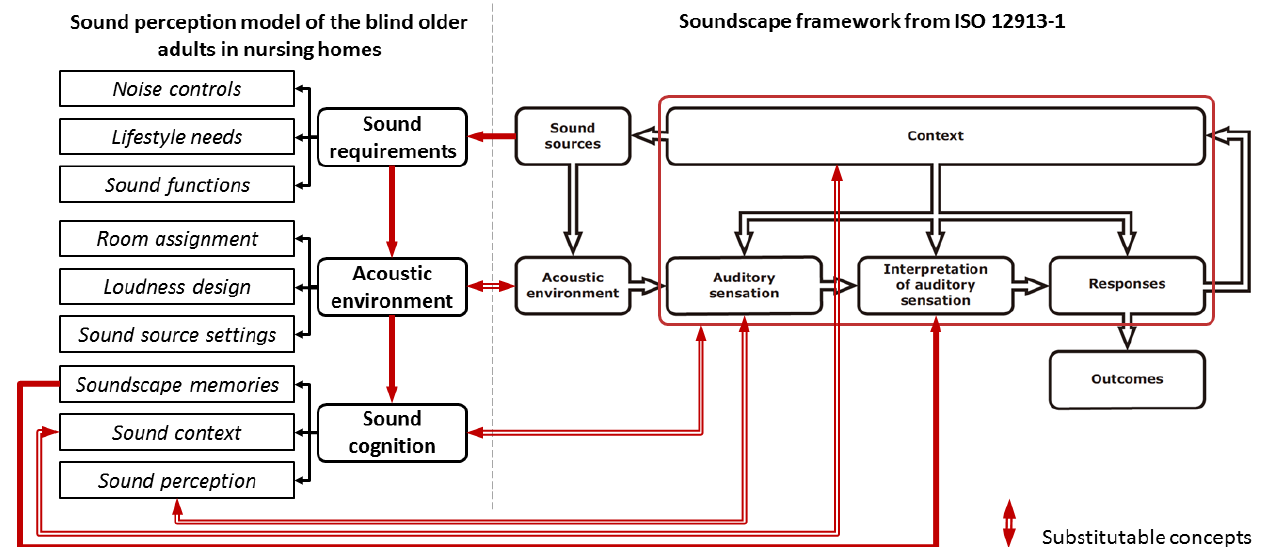
Figure 8. Differences between the sound perception framework of blind older adults and the ISO soundscape framework [31].